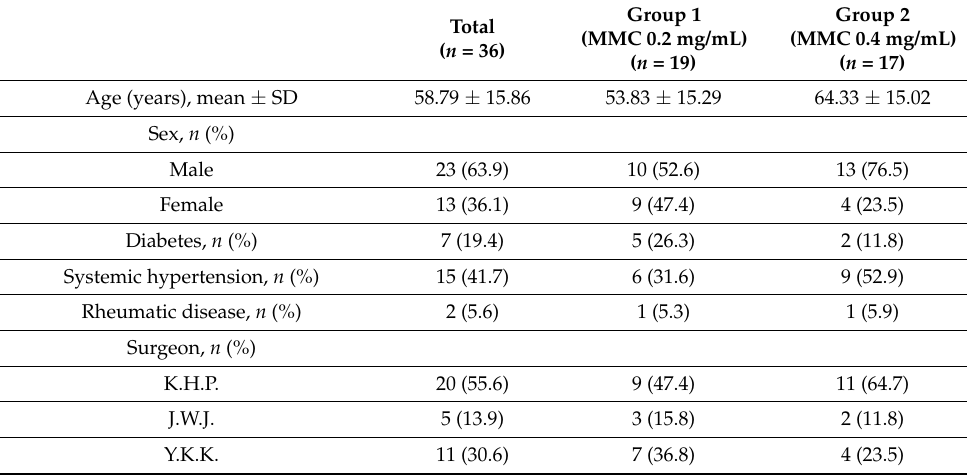
Figure 1. Flow chart according to Consolidated Standards of Reporting Trials (CONSORT). Table 1. Demographics and clinical characteristics .